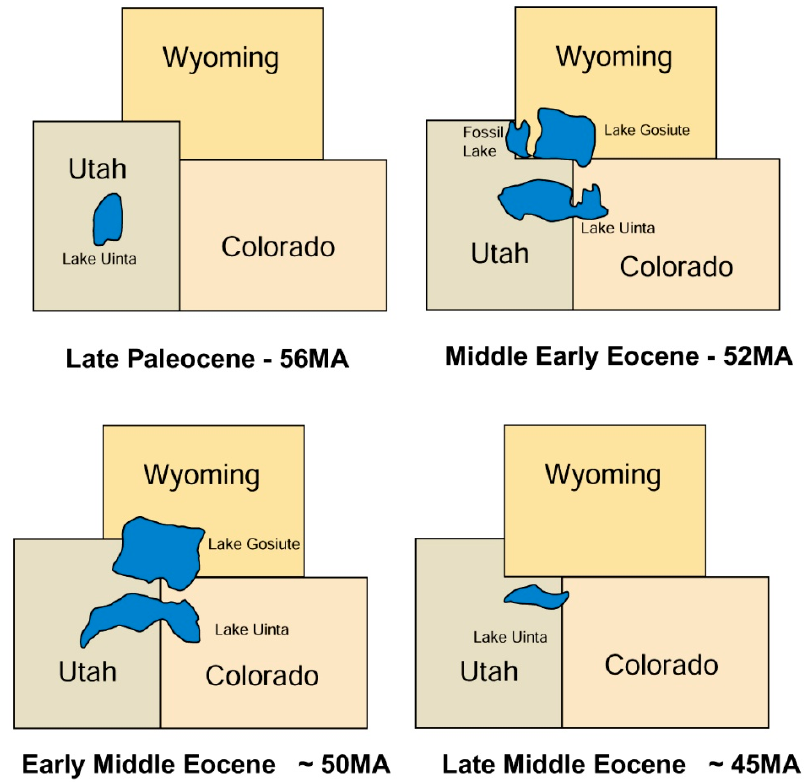
Figure 1. Green River Lake basin map modified from [1].